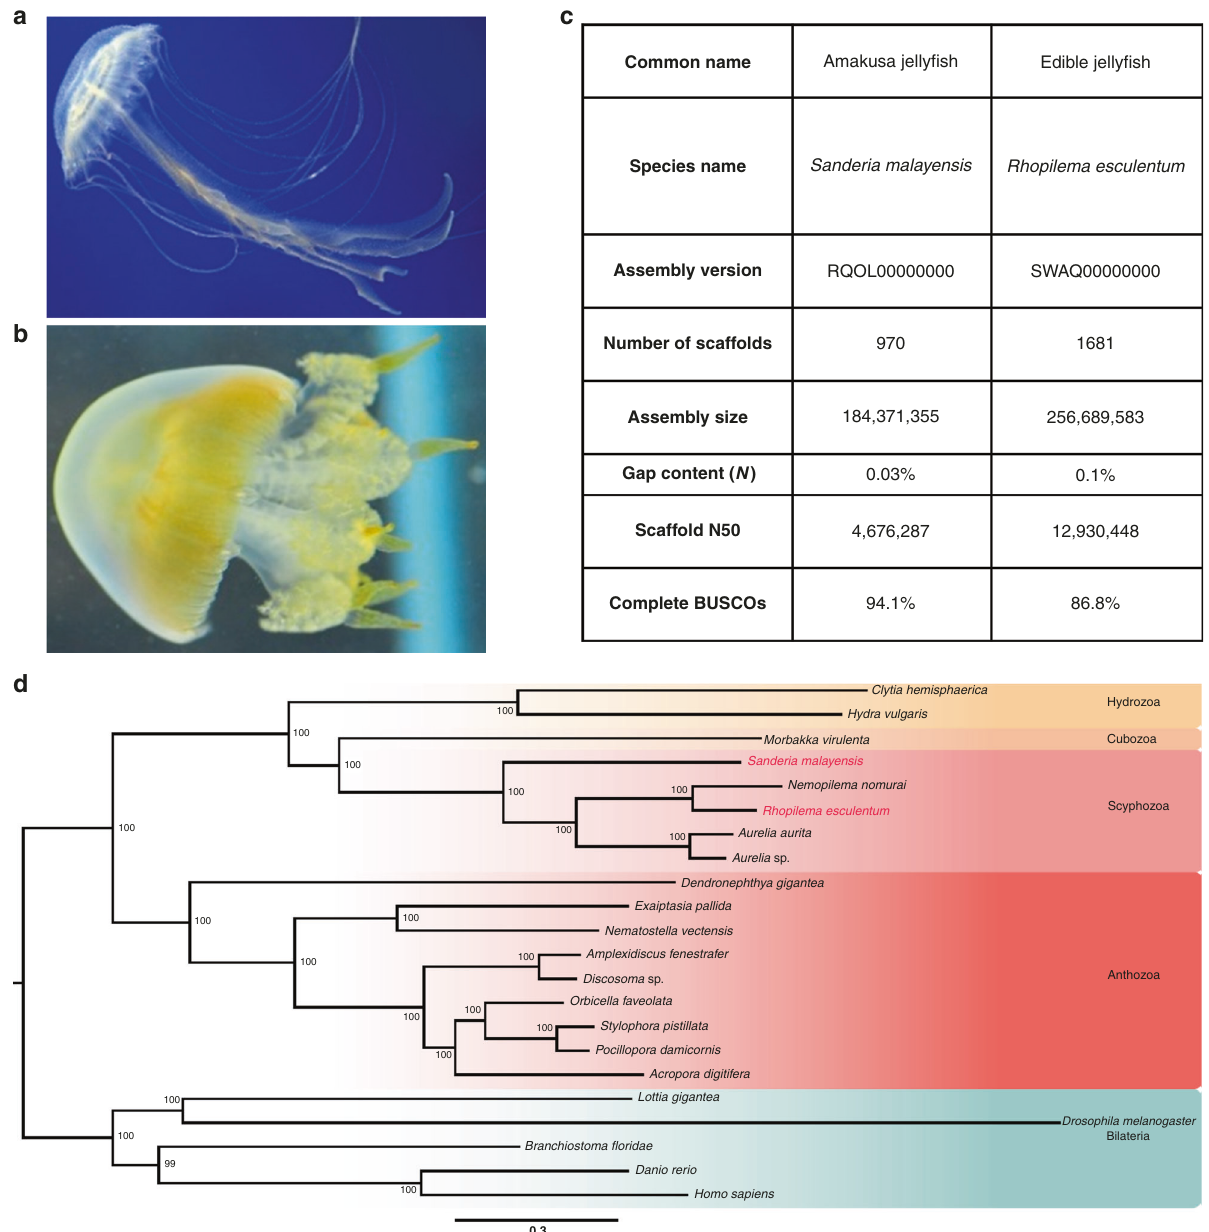
Fig. 1 The two jelly fi sh models used in this study and their phylogenetic positions. a Amuska jelly fi sh Sanderia malayensis ; b Edible jelly fi sh Rhopilema esculentum ; c Genome assembly quality. d Phylogenomic tree showing the positions of the two jelly fi sh (highlighted in